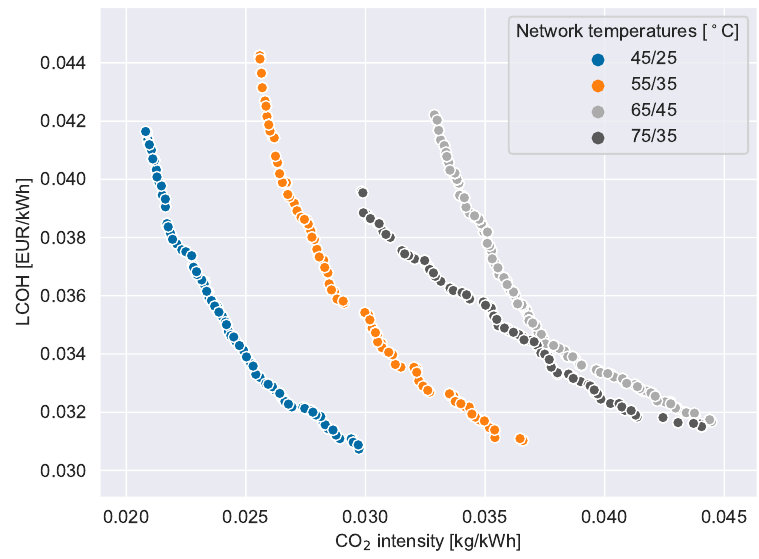
Figure 17. CO 2 intensity versus LCOH Pareto fronts for different temperature scenarios.